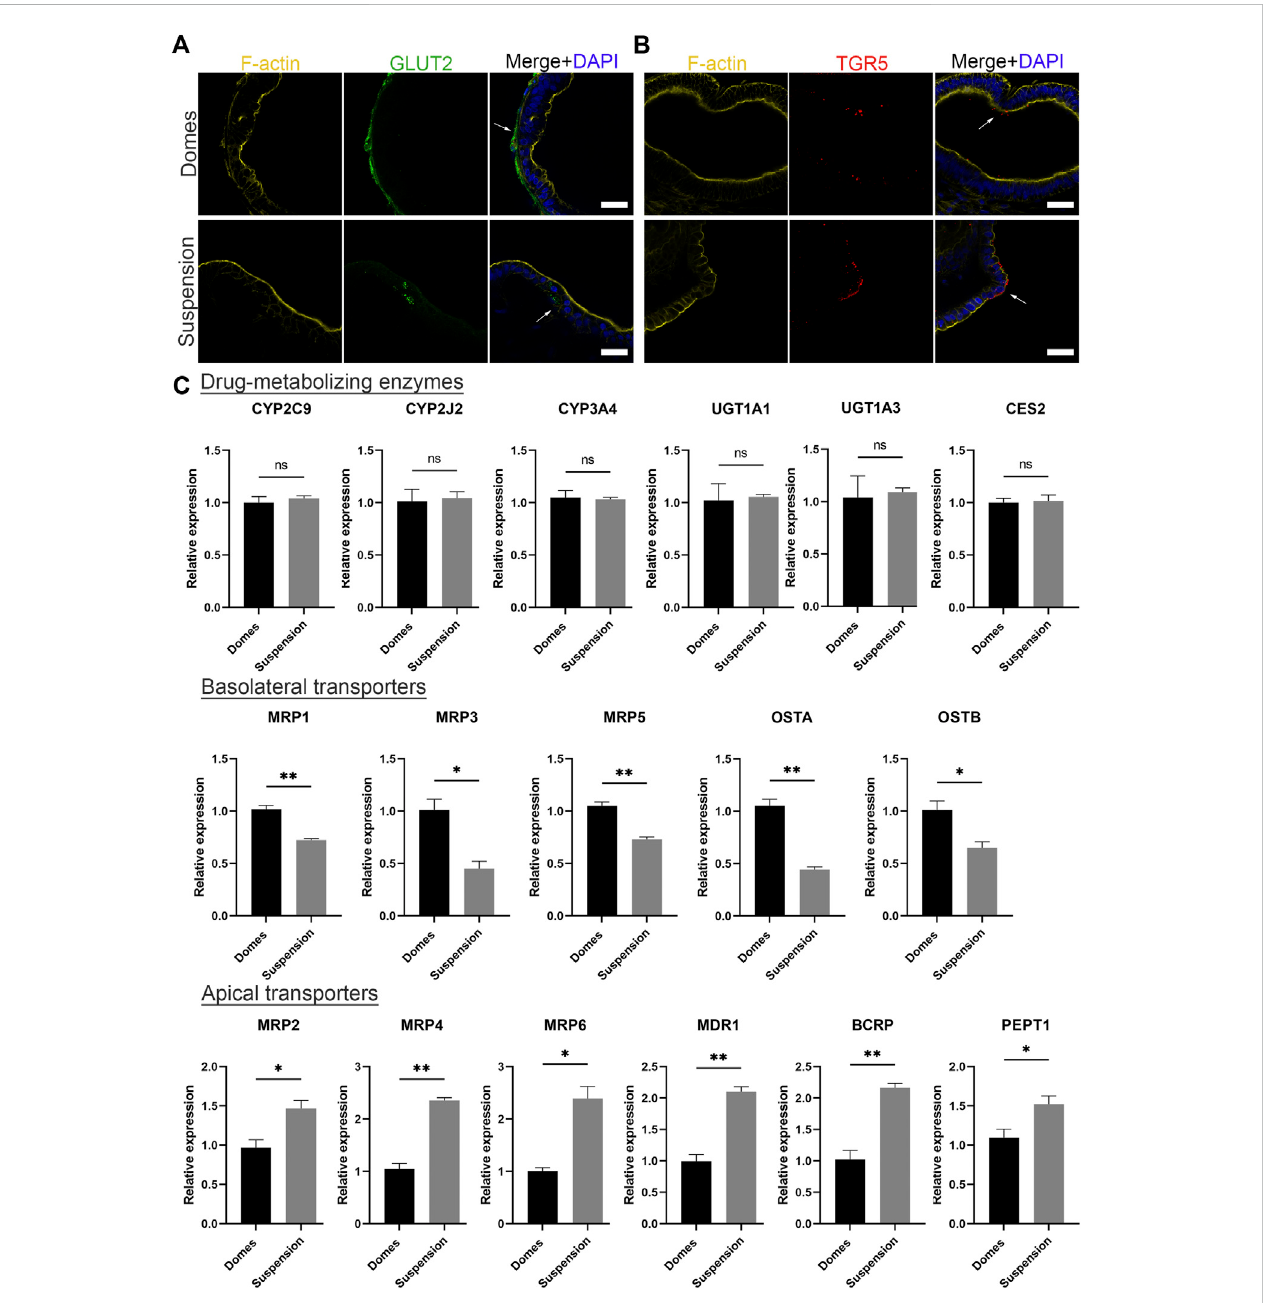
(blue) indicates cell nuclei. Scale bars: 50 μ m, and apply to the same group in each row. (C) Gene expression levels encoding drug-metabolizing enzymes ( CYP2C9, CYP2J2, CYP3A4, UGT1A1, UGT1A3 and CES2 ), basolateral transporters ( MRP1, MRP3, MRP5, OSTA and OSTB ) and apical transporters ( MRP2, MRP4, MRP6, MDR1, BCRP and PEPT1 ) were measured by real time RT-PCR. Error bars indicate mean ± S.E.M ( n =